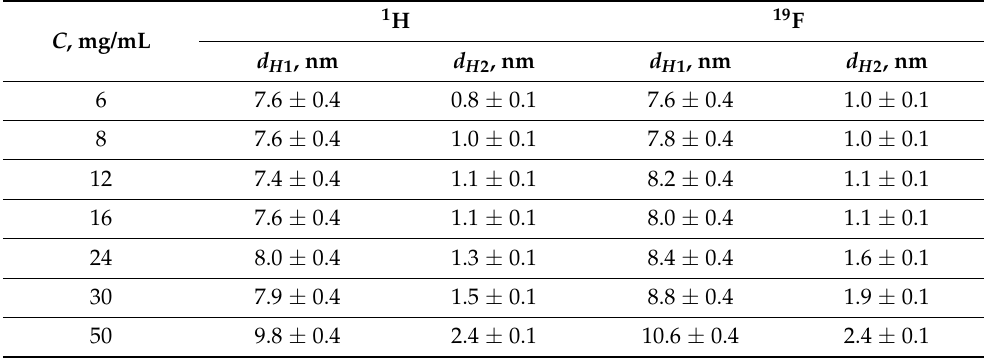
Table 4. Diameters of particles of compound X calculated on the basis of Equation (2) from self- diffusion coefficients measured for 1 H and 19 F nuclei.